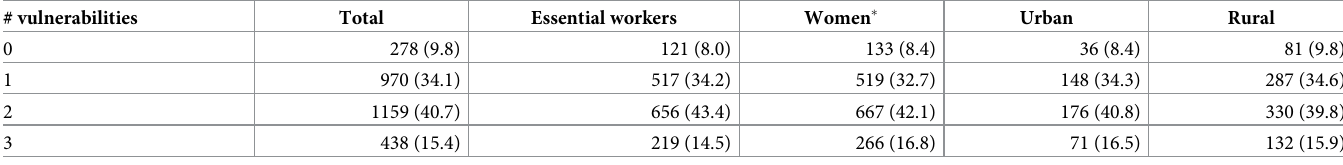
Table 3. Distribution of cumulative vulnerabilities by key